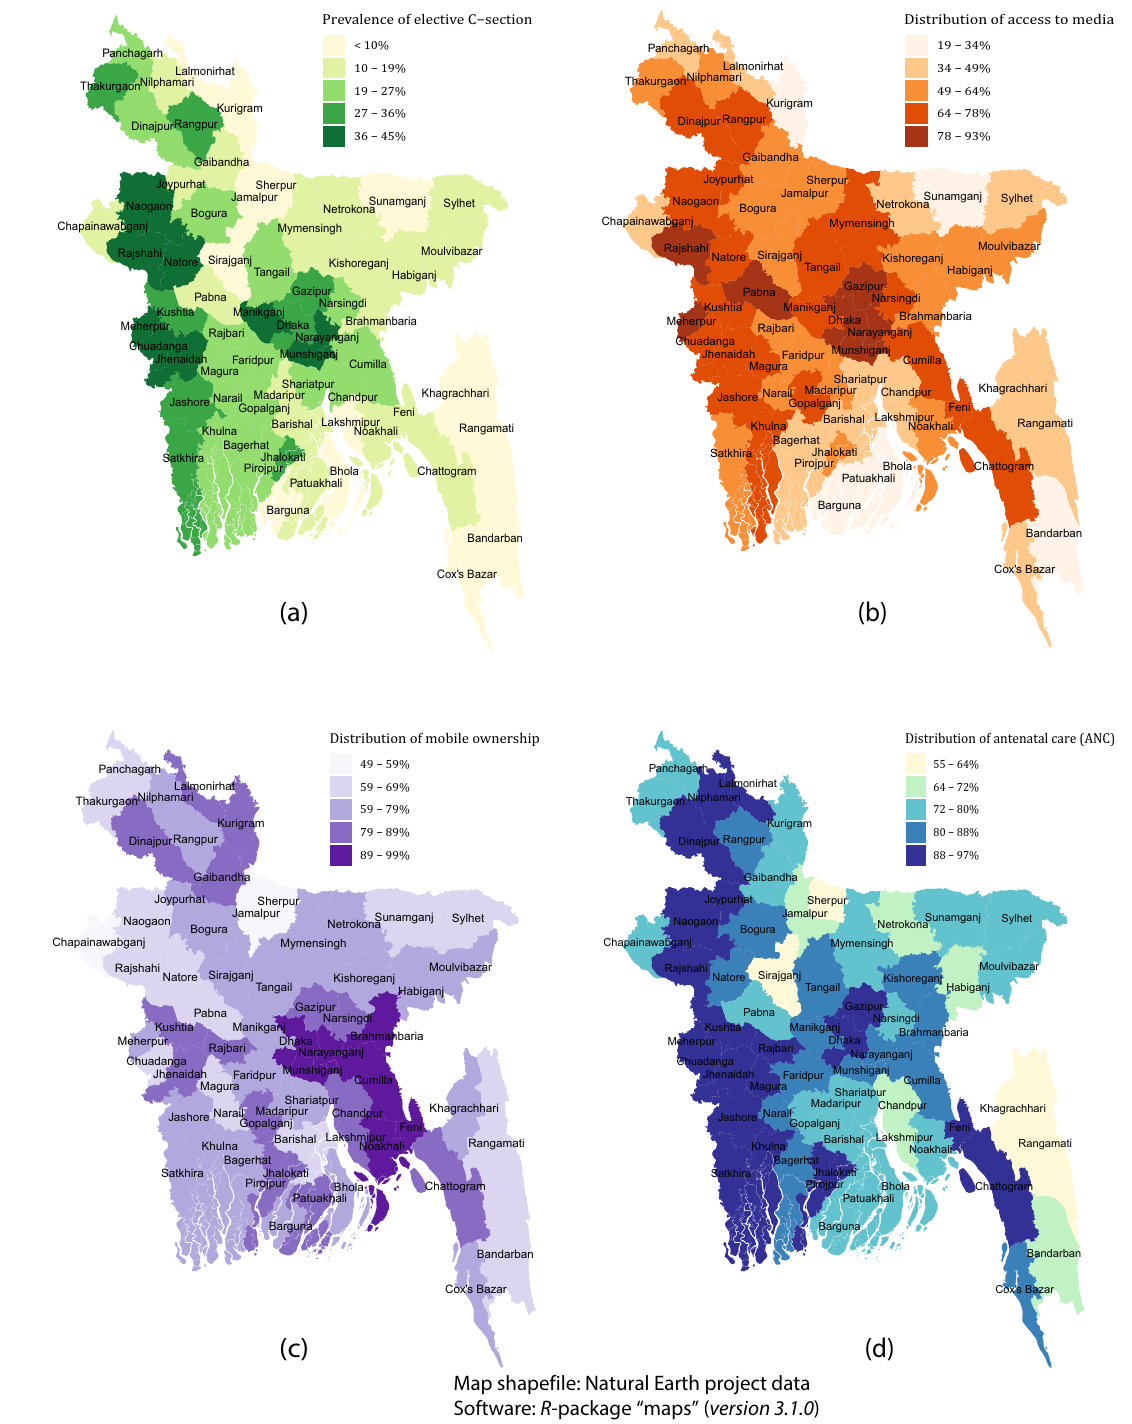
Map shapefile: Natural Earth project data Software: R -package “maps” ( version 3.1.0 ) Figure 2. District-wise spatial mapping on the distribution of ( a ) elective CS, ( b ) access to media, ( c ) mobile ownership, and ( d ) antenatal care